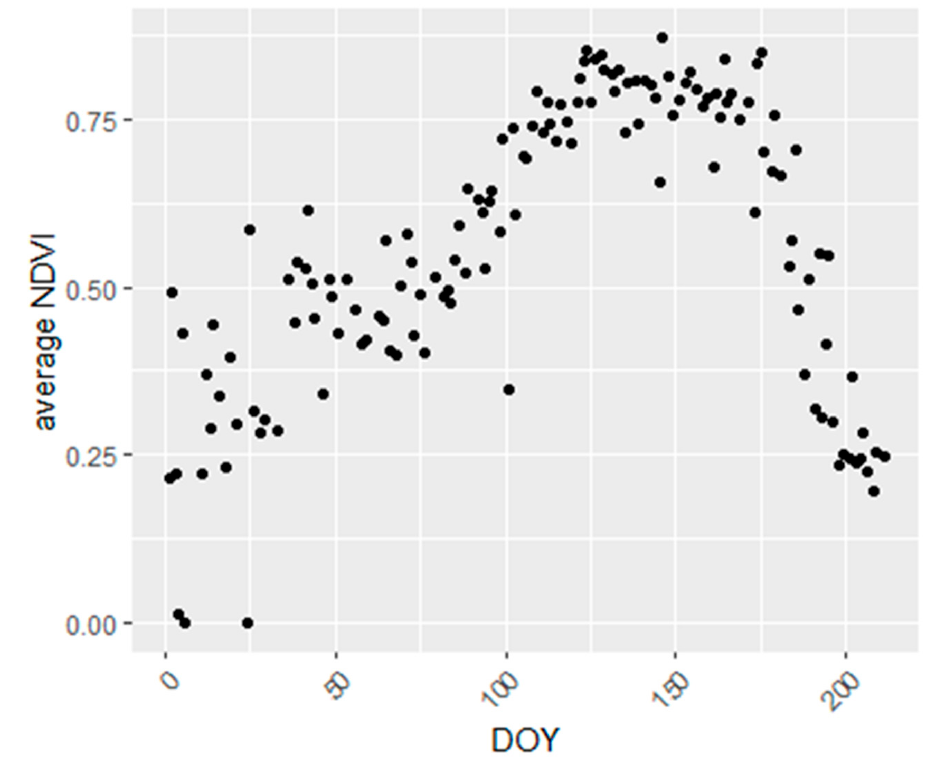
Figure 2. Average NDVI for the 1485 winter wheat fields studied from 2016 to 2018. DOY: day of year.